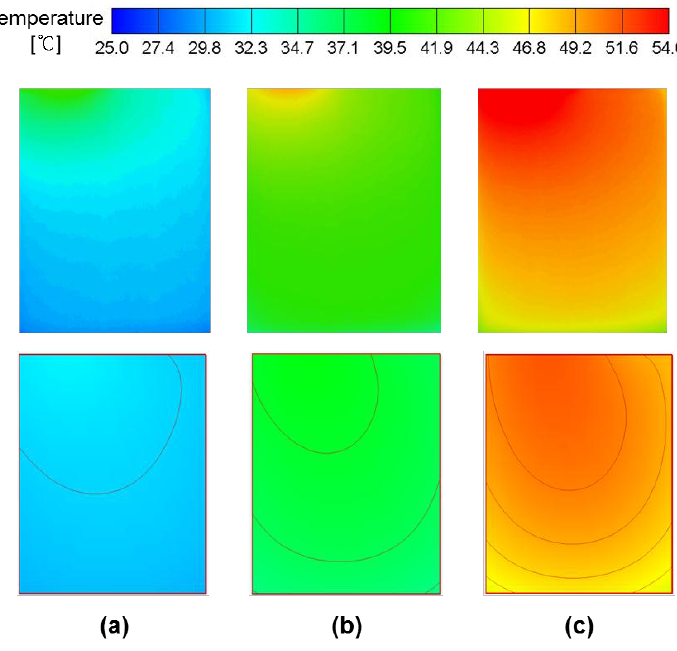
Figure 3. Temperature distributions based on the experimental IR image ( upper ) and the modeling ( lower ) for the LIB cell at the discharge times of ( a ) 300 s, ( b ) 600 s, and ( c ) 1200 s with 3 C rate.